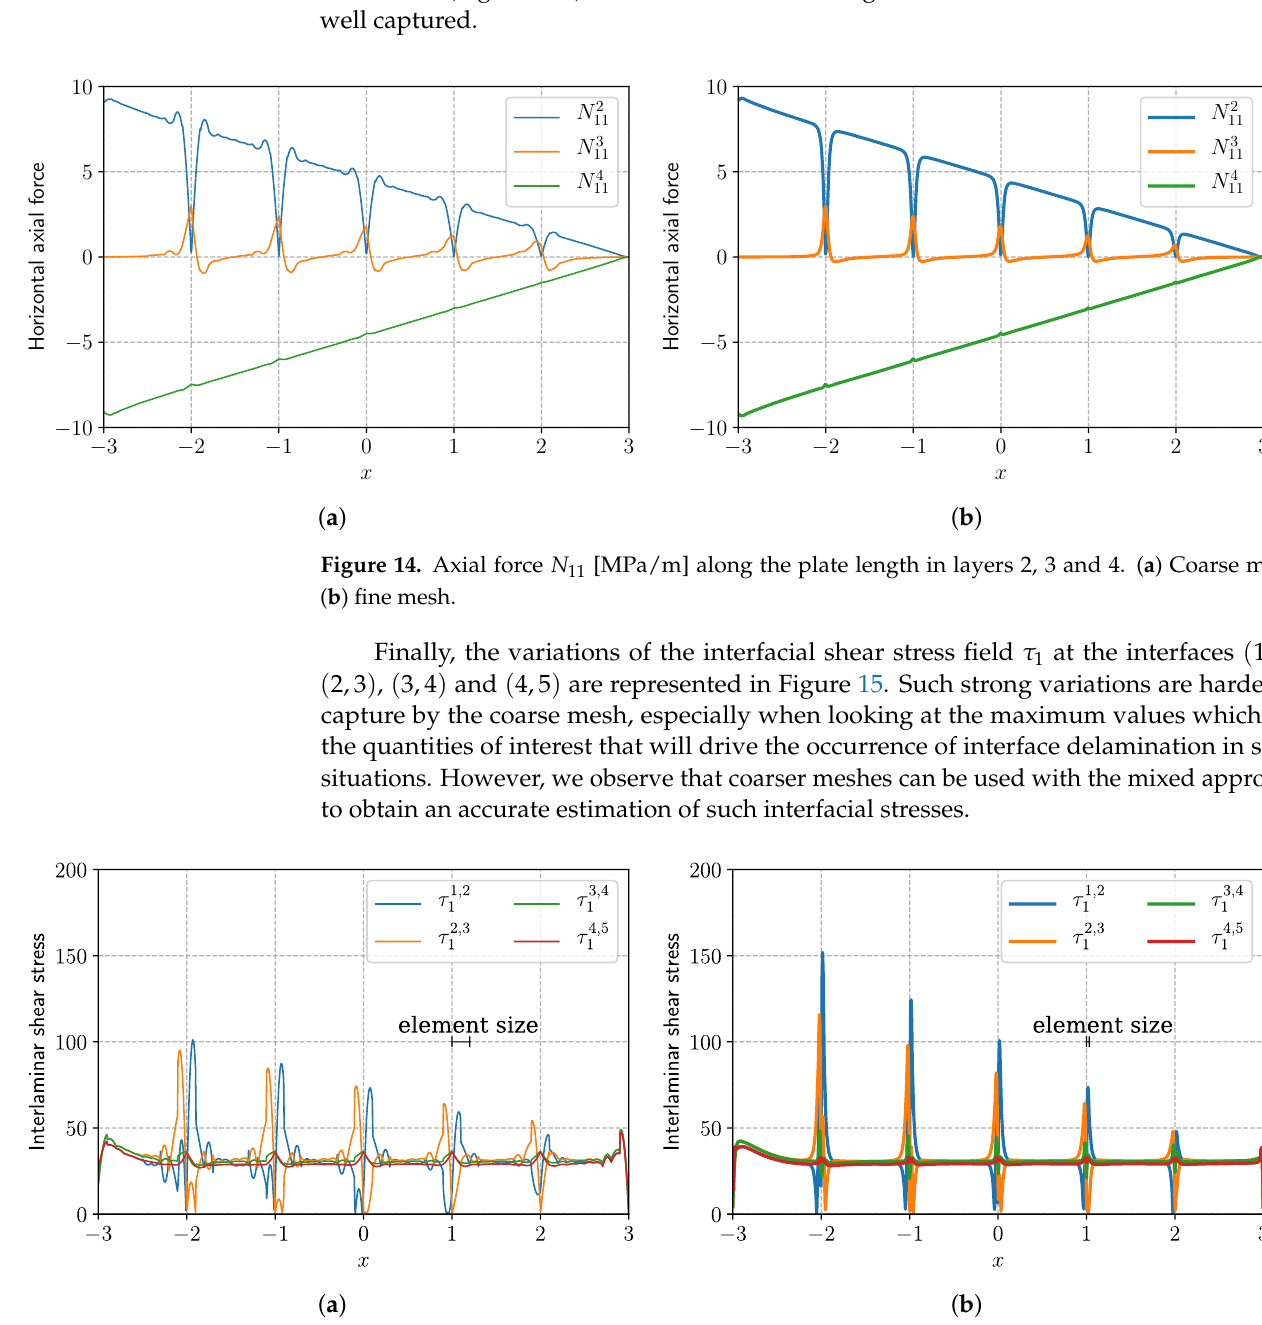
Figure 15. Interfacial stress τ 1 [MPa] along the plate length at all interfaces. ( a ) coarse mesh; ( b ) fine